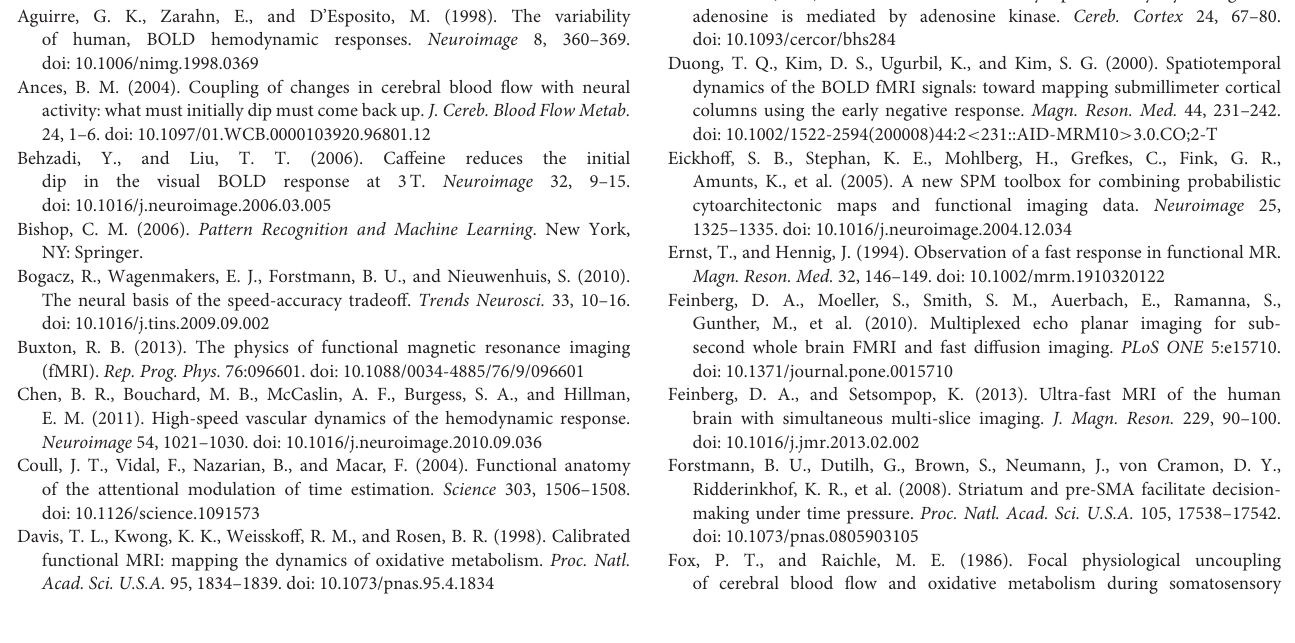
Supplementary Figure 1 | Majority group mean HRFs in specific ROIs. Format is the same as Figure 6 but for the following ROIs: V1, V2, V3, V4, MT, premotor